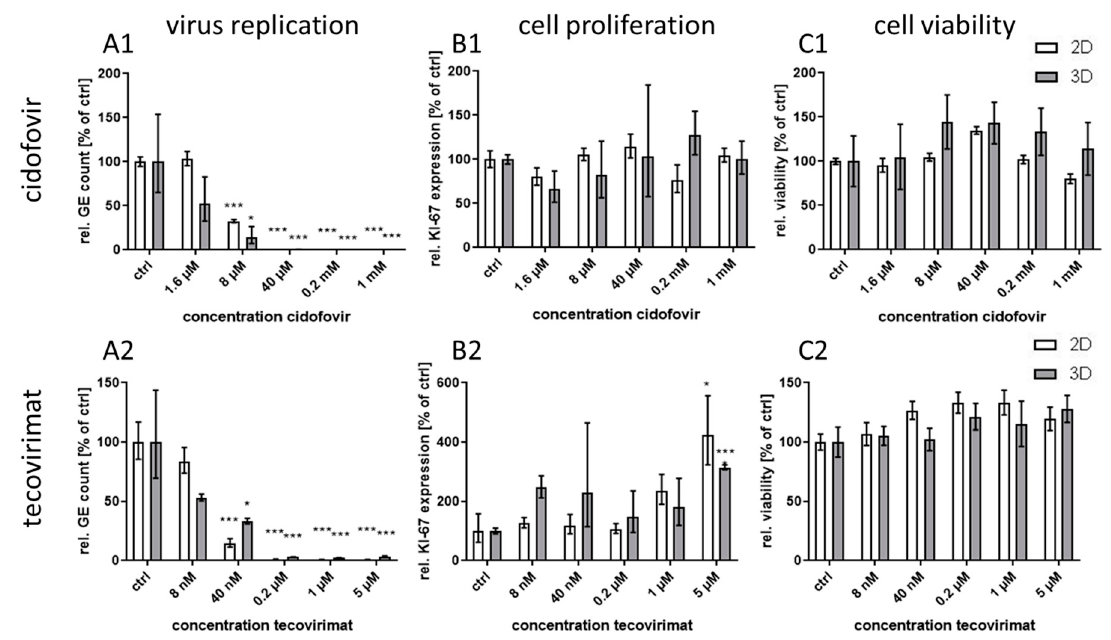
Figure 2. Effect of cidofovir and tecovirimat treatment on Cowpox virus (CPXV) infection in primary 3D and 2D cultures. NHEK were grown on decellularized extracellular matrix and infected with CPXV. Infected cells were treated with five concentrations ( n = 3) of cidofovir or tecovirimat. At 48 h post infection (p.i.) viral genome equivalents (GE) were quantified via qPCR and expressed as GE per cell. All receptor tyrosine kinase inhibitor (RTKI)-treated samples were normalized to infected untreated controls ( A ). Expression of the cellular proliferation marker KI-67 ( B ) was determined via qPCR, normalized to the cellular reference gene MYC , and presented relative to the untreated controls. Statistical significance of reduction relative to the respective controls was calculated by two-tailed Student’s t -test (* p < 0.05, *** p < 0.001). Cell viability was determined by ATP measurement with the cell viability assay CellTiter-Glo ® (Promega). Infected but untreated controls ( n = 2) were taken as 100%. Ratios of treated samples ( n = 2) to corresponding controls are illustrated as relative viability ( C ).